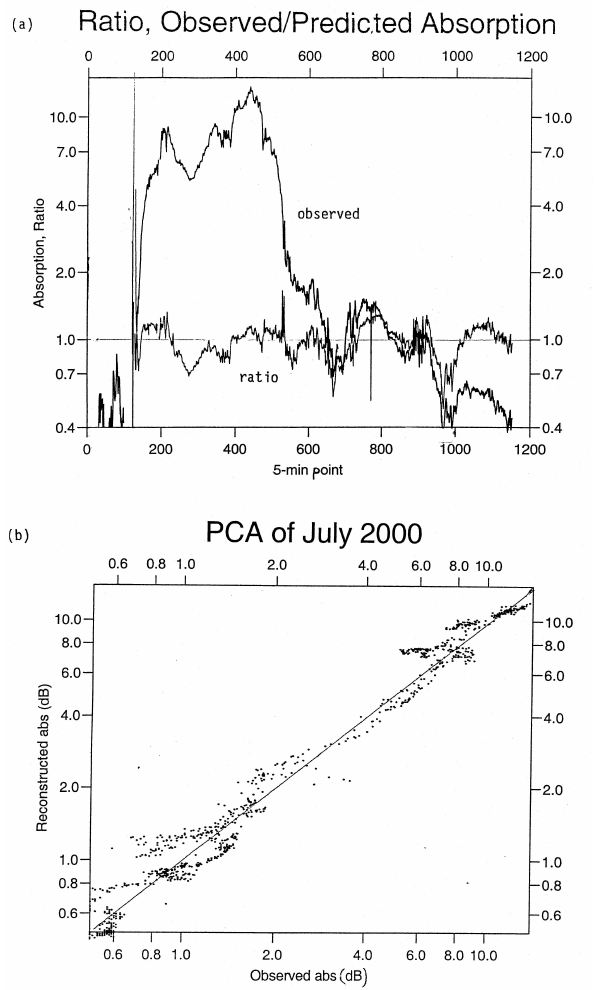
Fig. 8. Comparisons between observed and reconstructed absorp- tion, July 2000 all during daytime. (a) Ratio of observed to pre- dicted absorption. (b) Reconstructed against observed absorption, showing overall linearity.